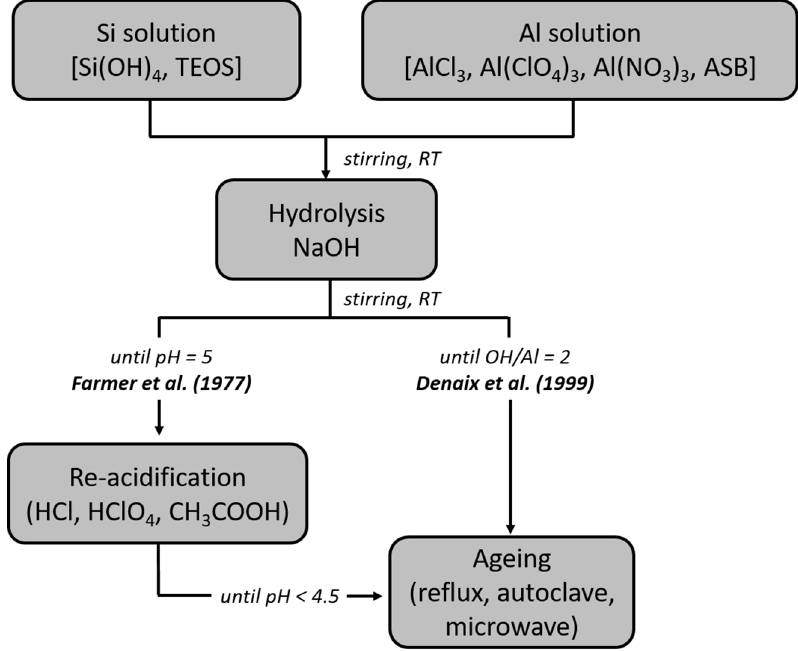
Figure 2. Flowchart for the two main synthesis methods of imogolite nanotubes: Farmer et al. [22]; Denaix et al. [38]. TEOS: tetraethylorthosilicate; ASB: Aluminum tri-sec-butoxide.